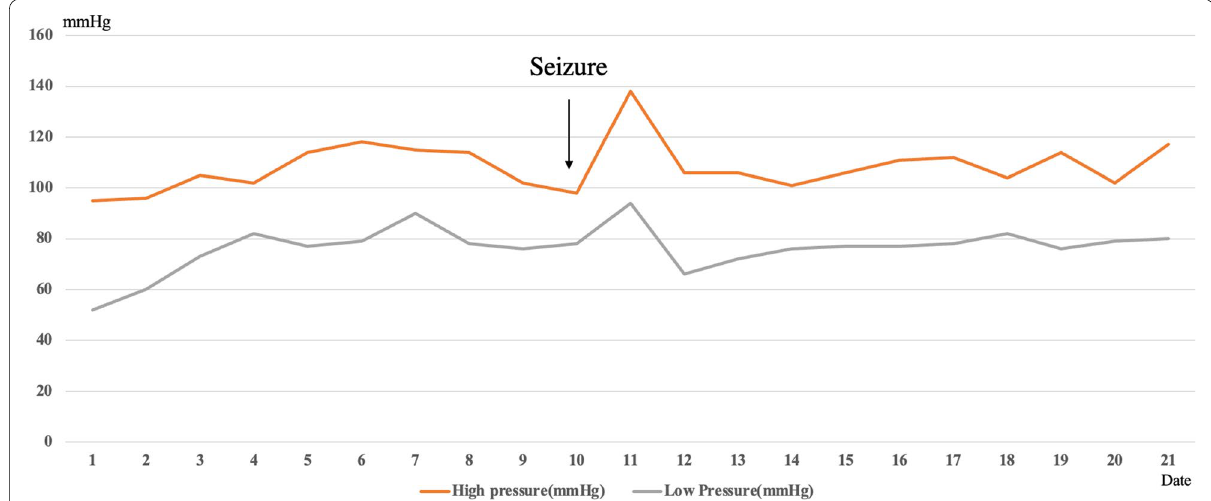
Fig. 2 Blood pressure fluctuations of case 1. The horizontal presents length of in-hospital stay. Blood pressure elevation started after seizure attack at Day 9. It was controlled and remain stable Since Day